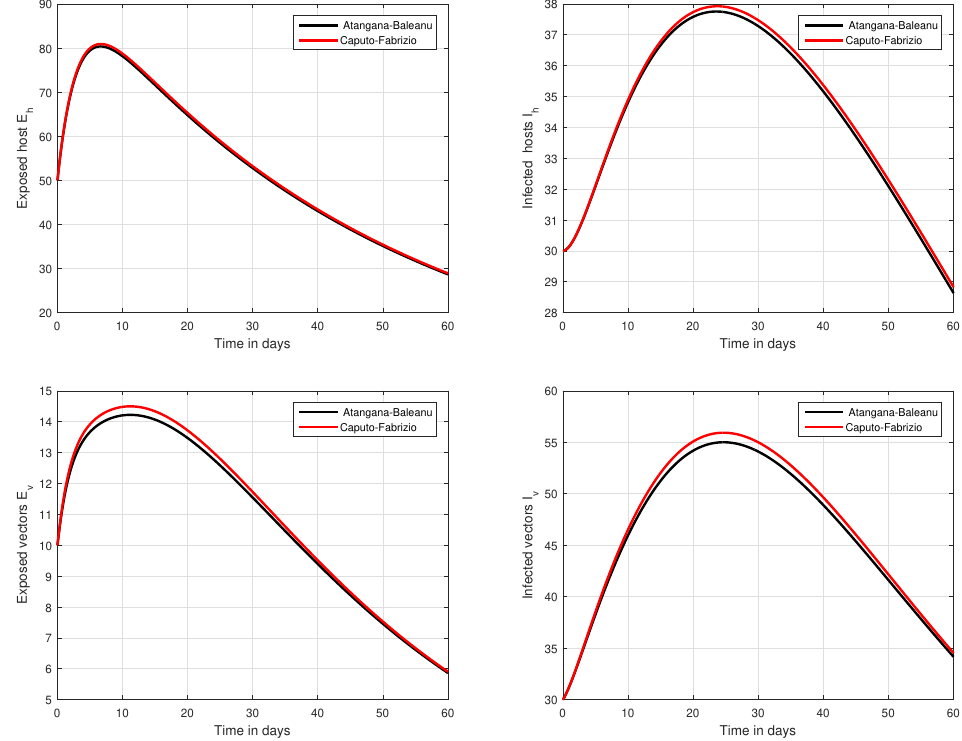
Figure 9. Comparative analysis of CF and ABC operators through the proposed